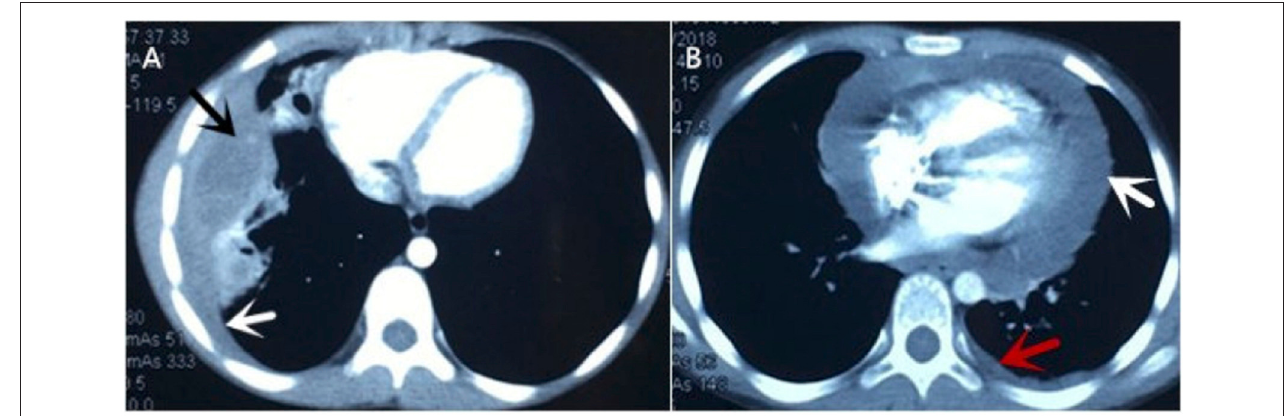
FIGURE 1 | Chest CT of current cases. (A) It showed abscess in the middle and lower lobes of the right lung (black arrow), thickening of adjacent pleura, small amount of pleural effusion (white arrow). (B) It revealed large pericardial effusion (white arrow) and a small amount of pleural effusion on the left (red arrow).